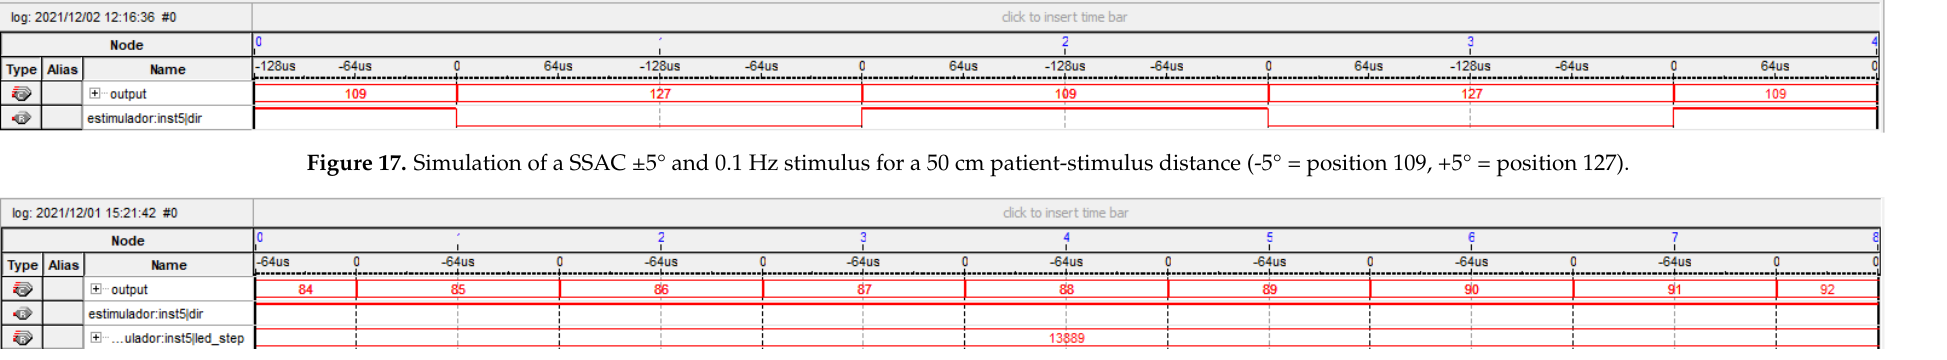
Figure 18. An extract of a period simulation for a SPCS ±10° and 0.5 Hz stimulus for a 100 cm patient-stimulus distance.